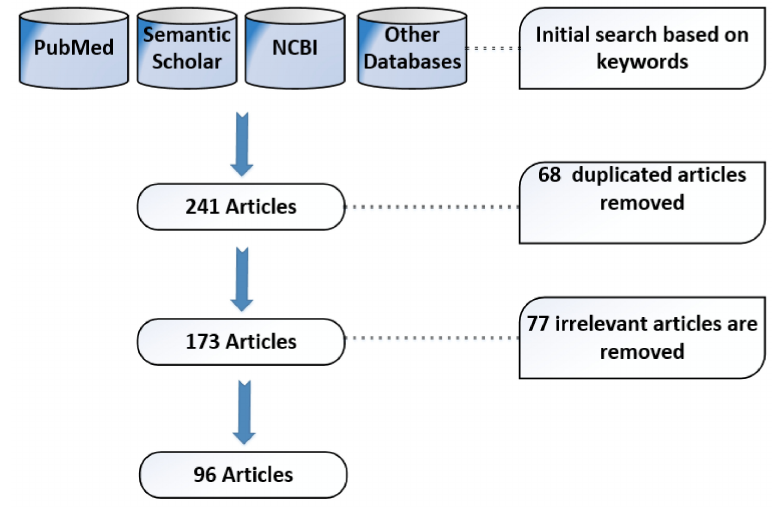
Figure 3. Resource databases and article screening.